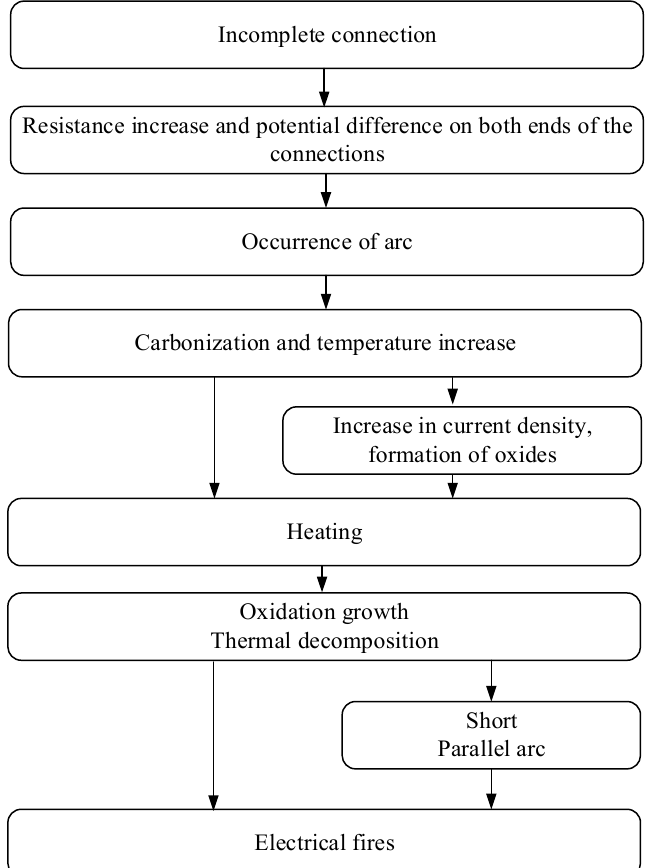
Figure 3. Typical mechanism of fire generation by a series arc.